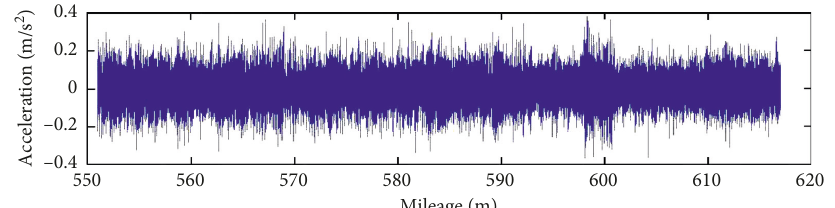
Figure 17: Signal sample of vehicle vertical acceleration.